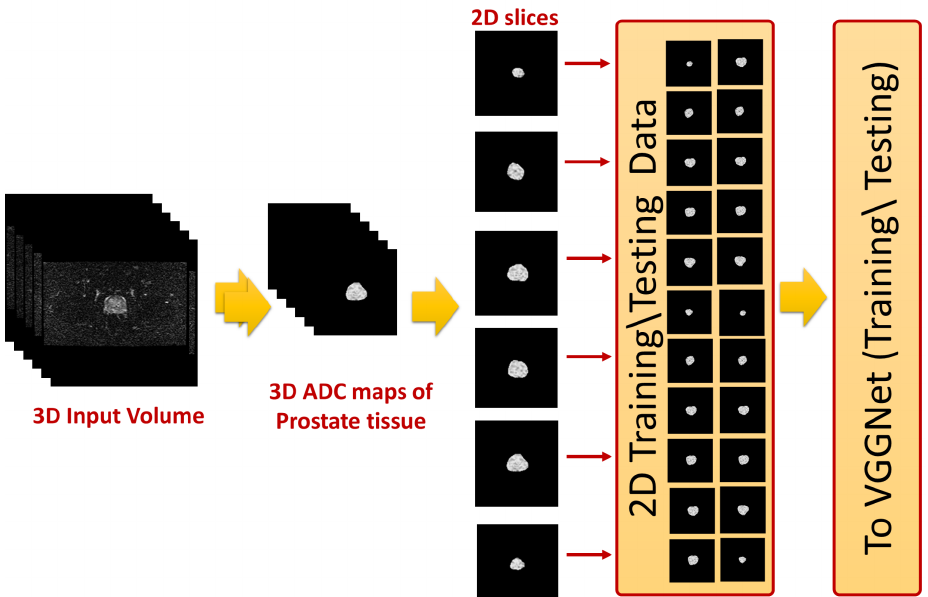
Figure 3. Illustration of slice-wise analysis of ADC